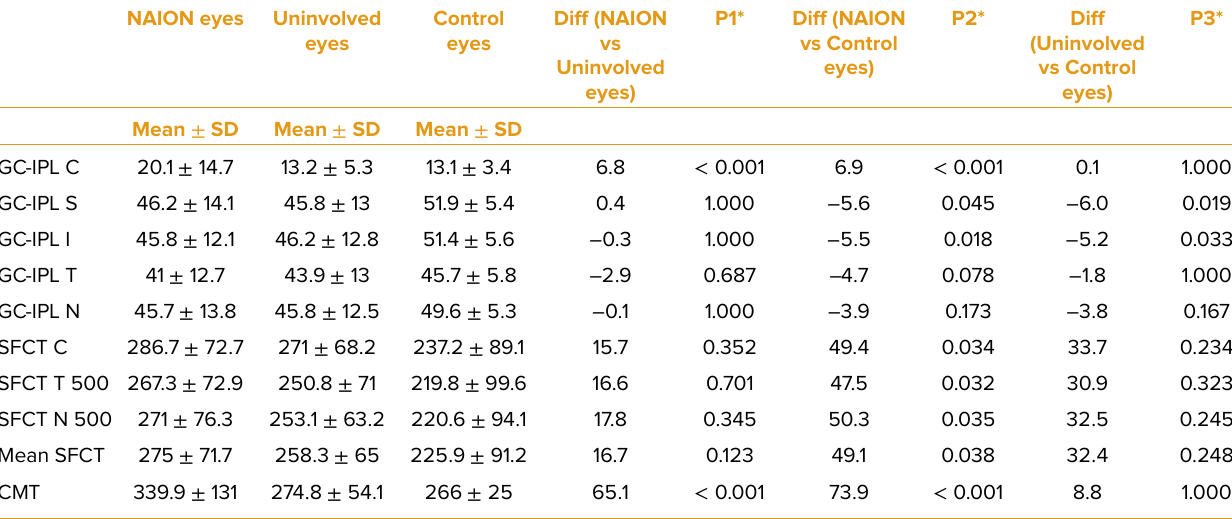
PCT, peri-papillary choroidal thickness; NAION, non-arteritic anterior ischemic optic neuropathy; S, superior; I, inferior; T, temporal; N, nasal; 1000, at 1000micron from Bruch’s membrane opening; 1500, at 1500micron from Bruch’s membrane opening; SD, standard deviation; Diff, difference * P-for pairwise comparison, based on post hoc analysis of GEE, adjusted for the multiple comparison by Bonferroni method Table 4. Measurements of GC-IPL, RFNL, SFCT and CMT in different areas in study groups (NAION, uninvolved, and control eyes) NAION